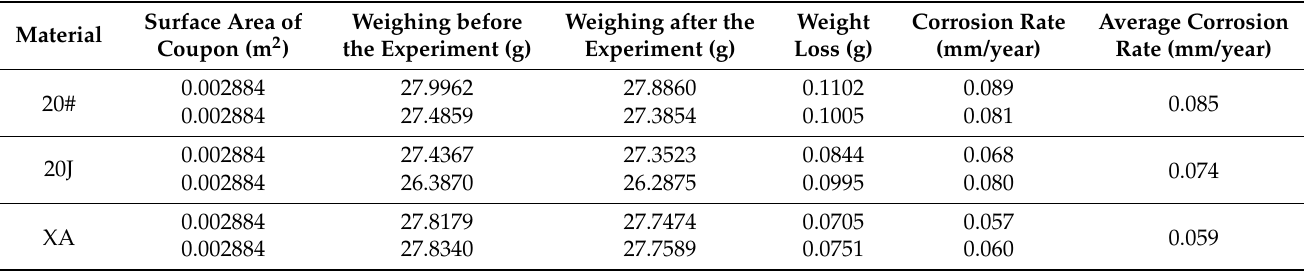
Table A1. Average corrosion rate in the case of CO 2 partial pressure of 0.1